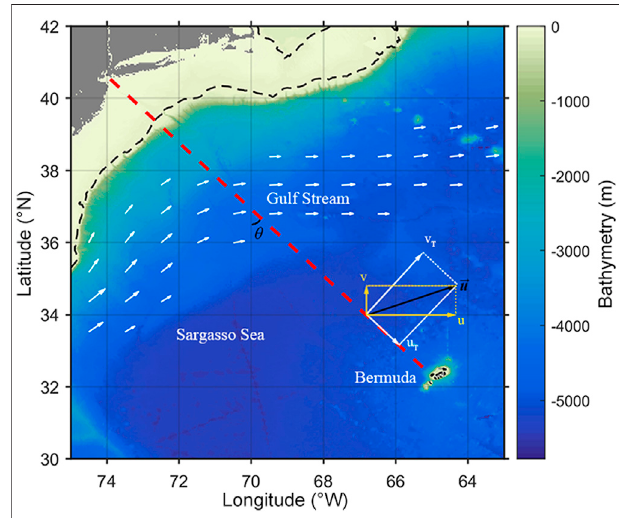
FIGURE 1 | Bathymetry of the region where the Oleander Project was conducted (the black dashed line is the 100 m isobath) and its ideal course track (the red dashed line). The thick white arrows are strong surface fl ow revealing the Gulf Stream path, the thin arrows are diagrams of the velocitytransformation, theyellow arrows aretheoriginalmeridional and zonal velocities,andthewhitearrowsarethealong-trackandacross-trackvelocities after transformation. Thetransformation isbasedontheangleofthetrackand the latitude, θ . The bathymetry data are taken from ETOPO2 (https://ngdc. noaa.gov/mgg/global/etopo2.html),andtheseasurfacevelocitydataarefrom ECCO Version 4 release 4 (https://ecco-group.org/products-ECCO-V4r4. htm, Forget et al., 2015; ECCO Consortium et al., 2021b,